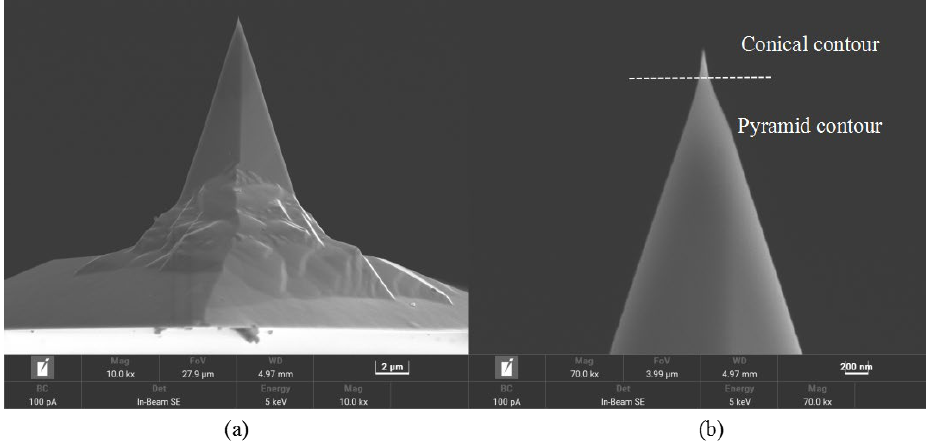
Figure 1. Unworn probe tip morphology: ( a ) overall image of the probe; ( b ) locally enlarged image of the tip.